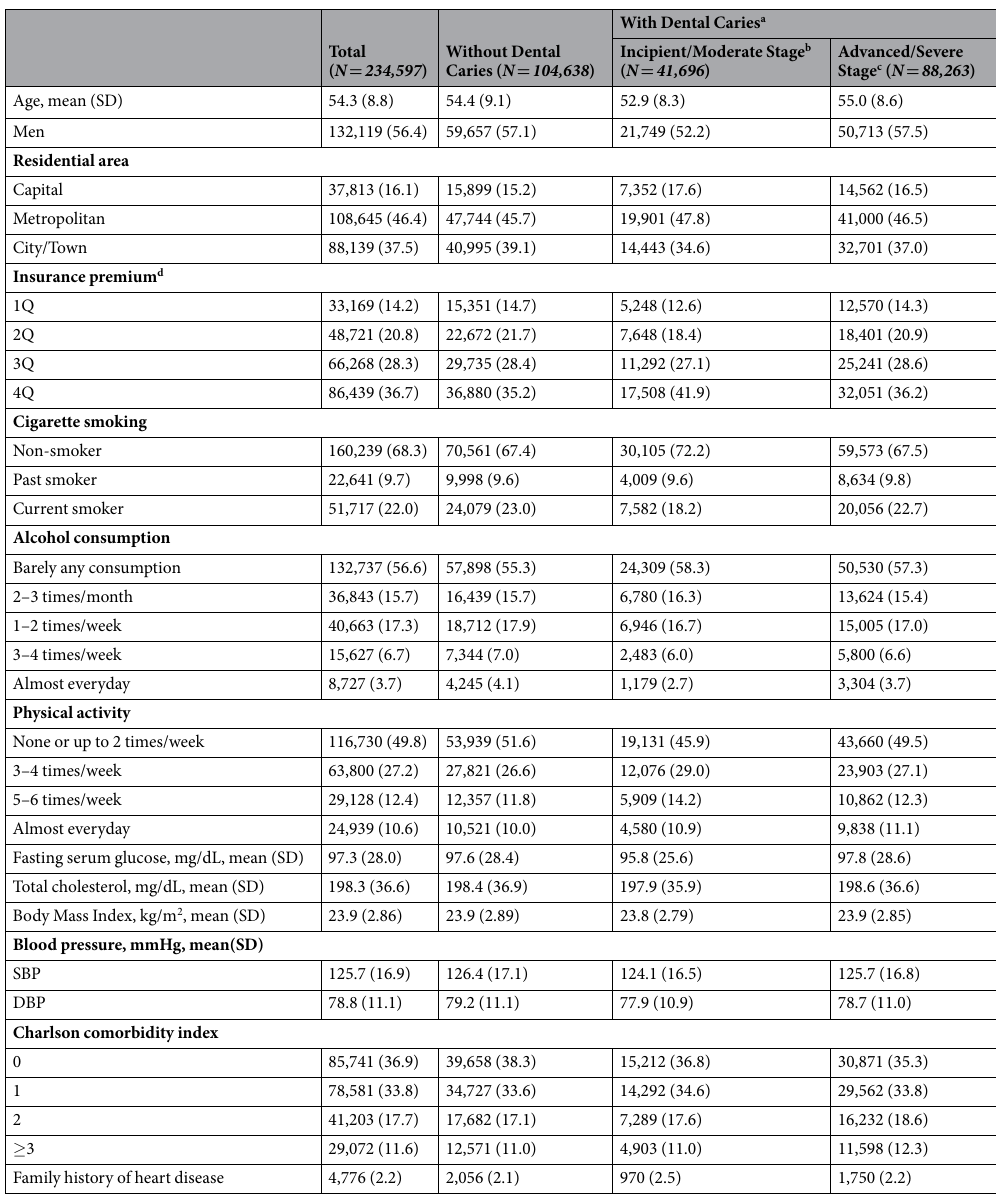
Table 1. Baseline sociodemographic, lifestyle, and medical characteristics of the patients in the National Health Insurance Service-Health Screening Cohort (NHIS-HEALS) according to dental caries status. Data above are presented as n(%) unless otherwise noted. a Includes ICD-10 codes for dental caries with at least 2 outpatient visits. b Includes ICD-10 codes for dental caries limited to enamel (K02.0), dental caries of dentin (K02.1), dental caries of cementum, arrested dental caries (K02.3), other dental caries (K02.8), and unspecified dental caries (K02.9) with at least 2 outpatient visits. c Includes ICD-10 codes for irreversible pulpitis (K04.0), necrosis of